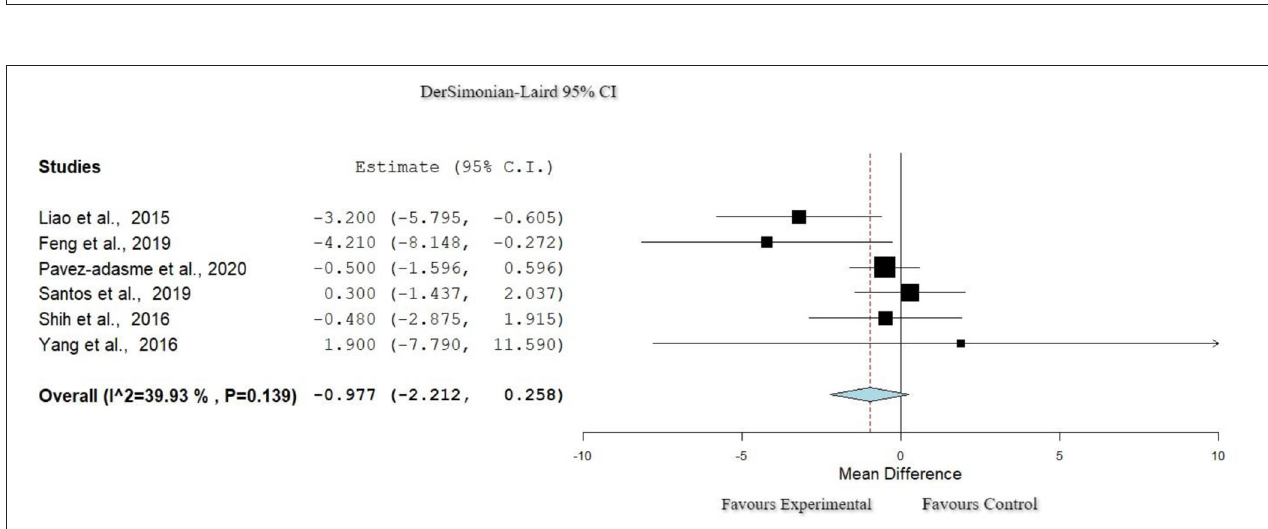
FIGURE 5 | Forest plot for Function: BBS. The red dash line represents the weighted mean difference of the included studies. The blue figure represents the weighted 95% CI of the included studies. BBS, Berg Balance Scale.